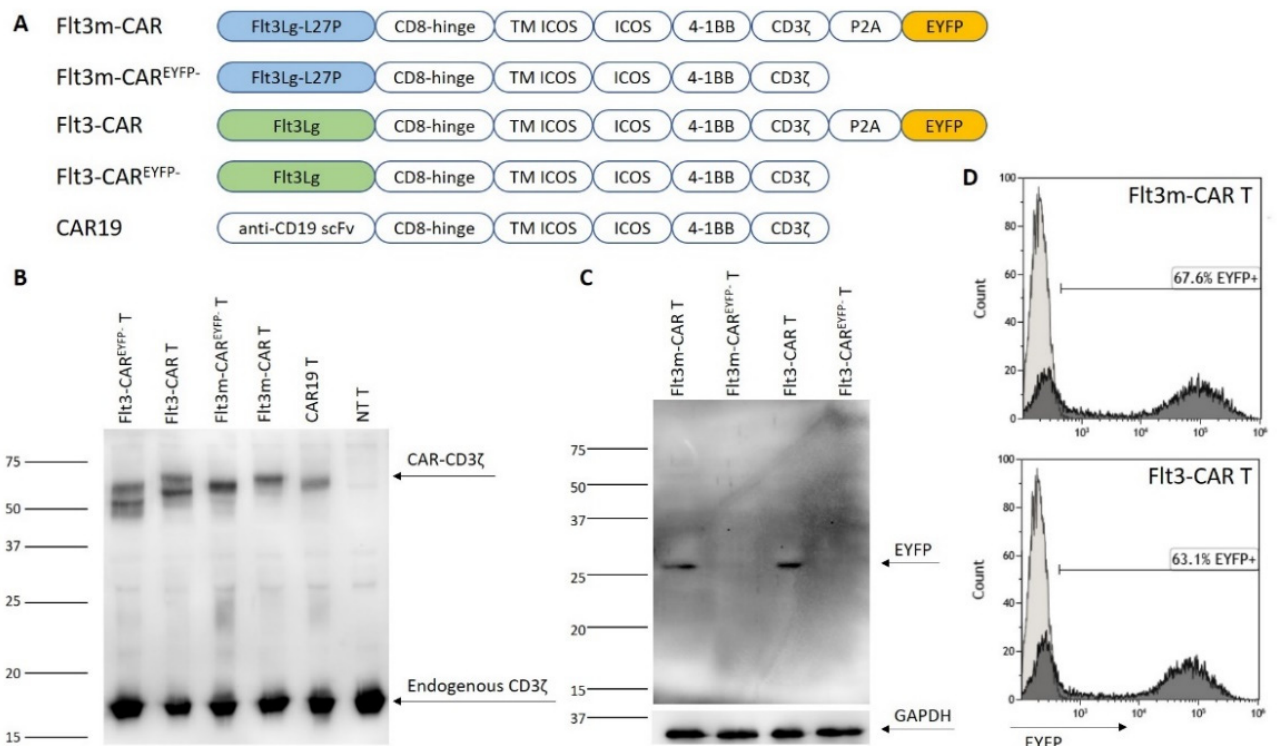
Figure 2. Generating Flt3-CAR T-cells. ( A ) Schematic structure of Flt3m-CAR, Flt3m-CAR EYFP − , Flt3-CAR, Flt3-CAR EYFP − , and CAR19 coding regions. ( B ) In the Western blot images, the synthesis of chimeric antigen receptors was demonstrated. The bands corresponding to the CD3 ζ chain that belongs to CAR receptors appeared in the lines with CAR T-cell lysates (50–60 kDa), but not in the line with non-transduced (NT) T-cell lysates. Bands corresponding to the CD3 ζ chain as part of endogenous T-cell receptors (16 kDa) are present in all lines. ( C ) Using the Western blot technique, the synthesis and proper cleavage of the EYFP protein in Flt3m-CAR T-cells was shown. Arrows indicate a single band of an appropriate size of EYFP (27 kDa). ( D ) EYFP synthesis in Flt3m-CAR T-cells was assessed on the seventh day after transduction using flow cytometry. A representative figure is shown. The experiments were performed at least three times.